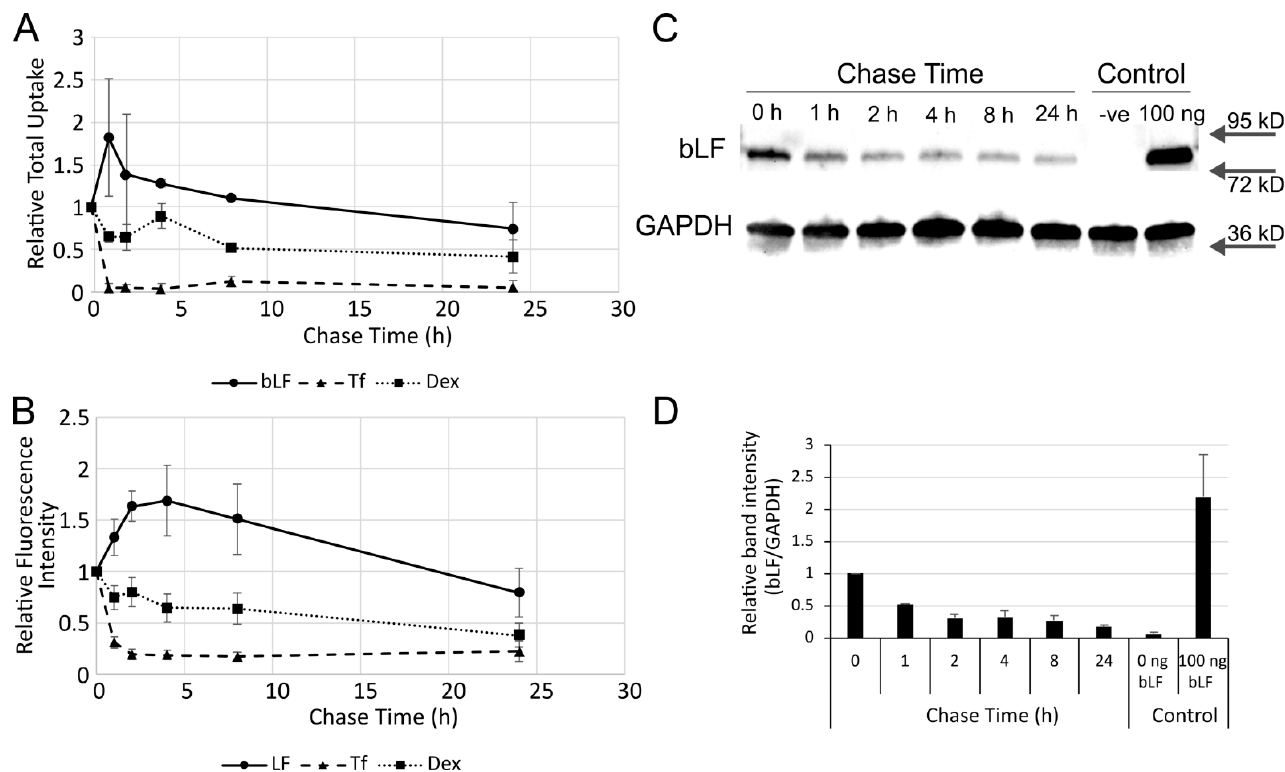
Figure 5. Quantification of trafficking. Cells were incubated with 500 nM bLF647, 100 µg/mL Dex647, or 20 nM Tf488 for 1 h in serum-free medium before being washed and incubated for between 0 and 24 h in serum-containing medium and imaged by confocal microscopy ( A ), flow cytometry ( B ), or Western blotting (( C , D ), 1 µM unlabelled bLF). To obtain relative total uptake ( A ), 10 images were quantified from each independent experiment and normalised to the 0 h chase period. Flow cytometry represents the mean of the median fluorescence from each independent experiment performed in duplicate (N = 3).